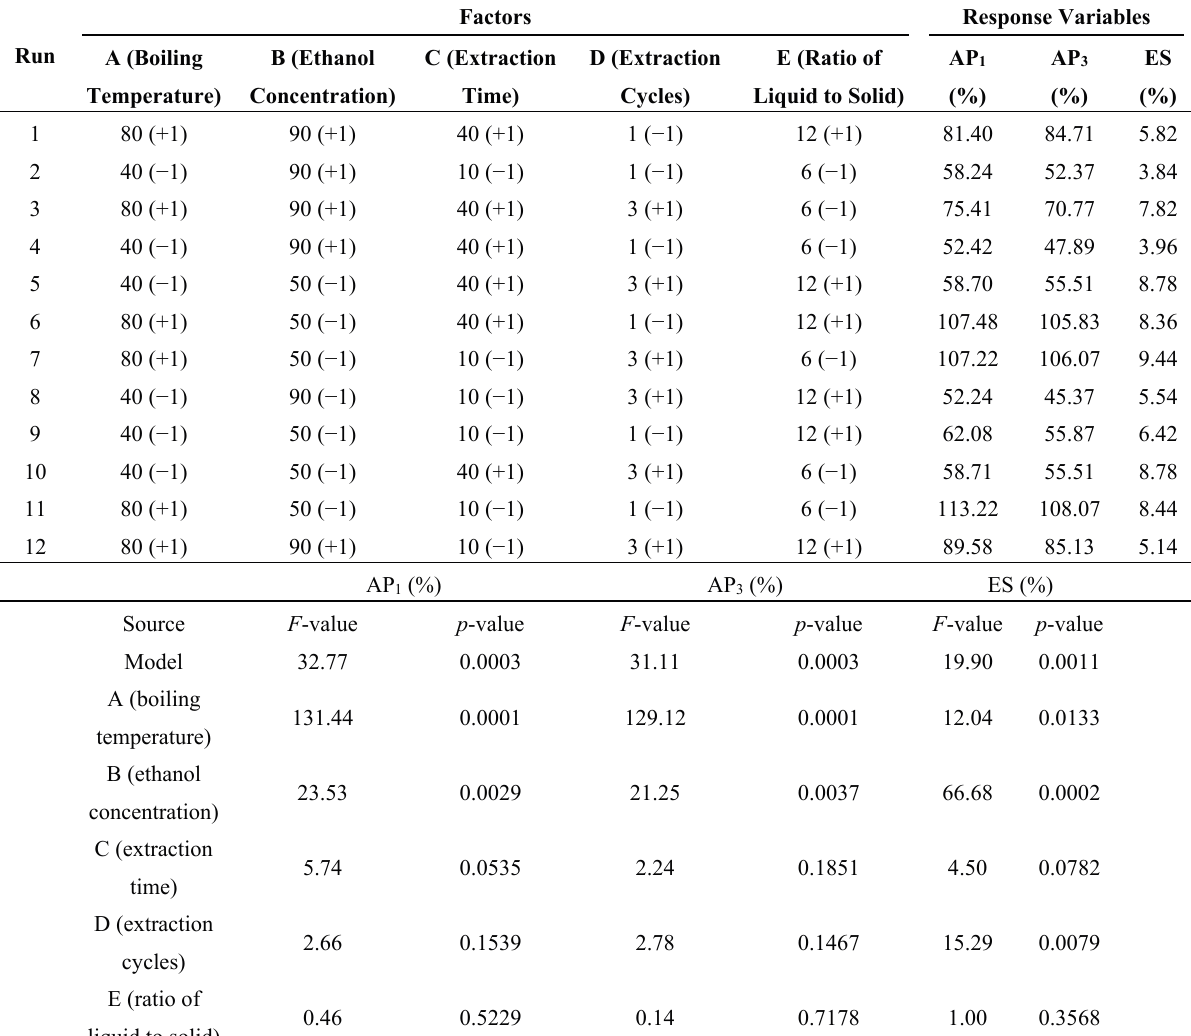
Table 2. Arrangement and results of the Placket-Burman